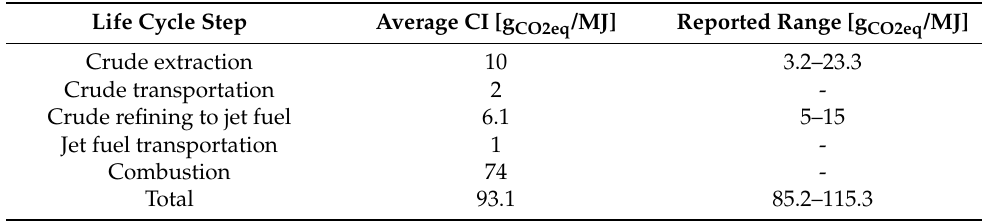
Table 1. Break-down of the EU CI baseline of fossil kerosene (Baseline